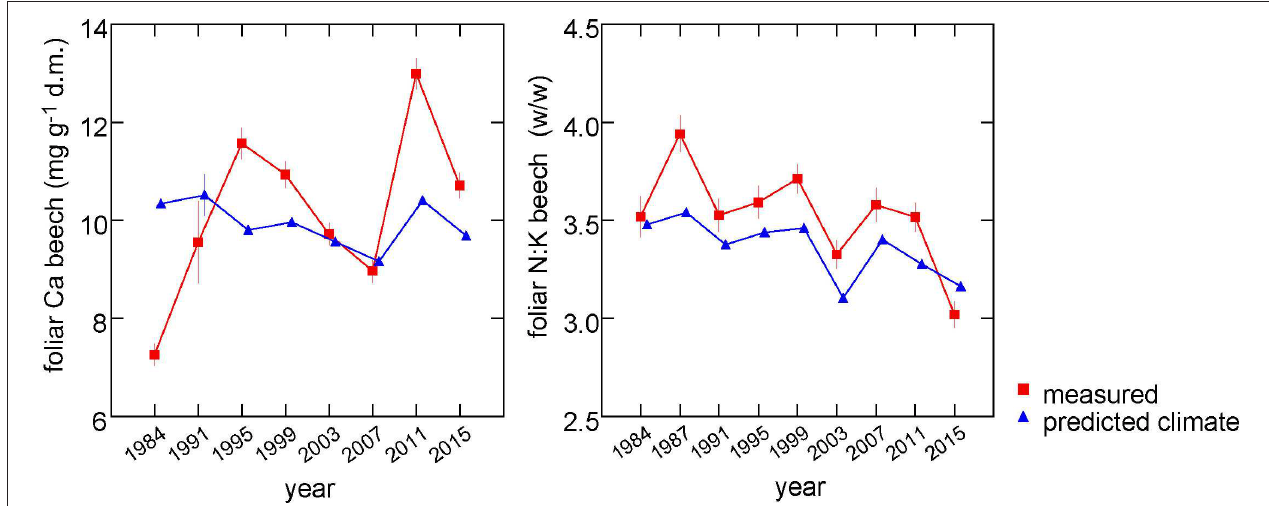
FIGURE 7 | Predictions from the regression model for Ca concentrations (left) and N:K ratio (right) with non-climatic variables set at their means (blue triangles). These predictions thus reflect the annual variations explained by climatic variables. The measured values are shown for comparison (red squares).